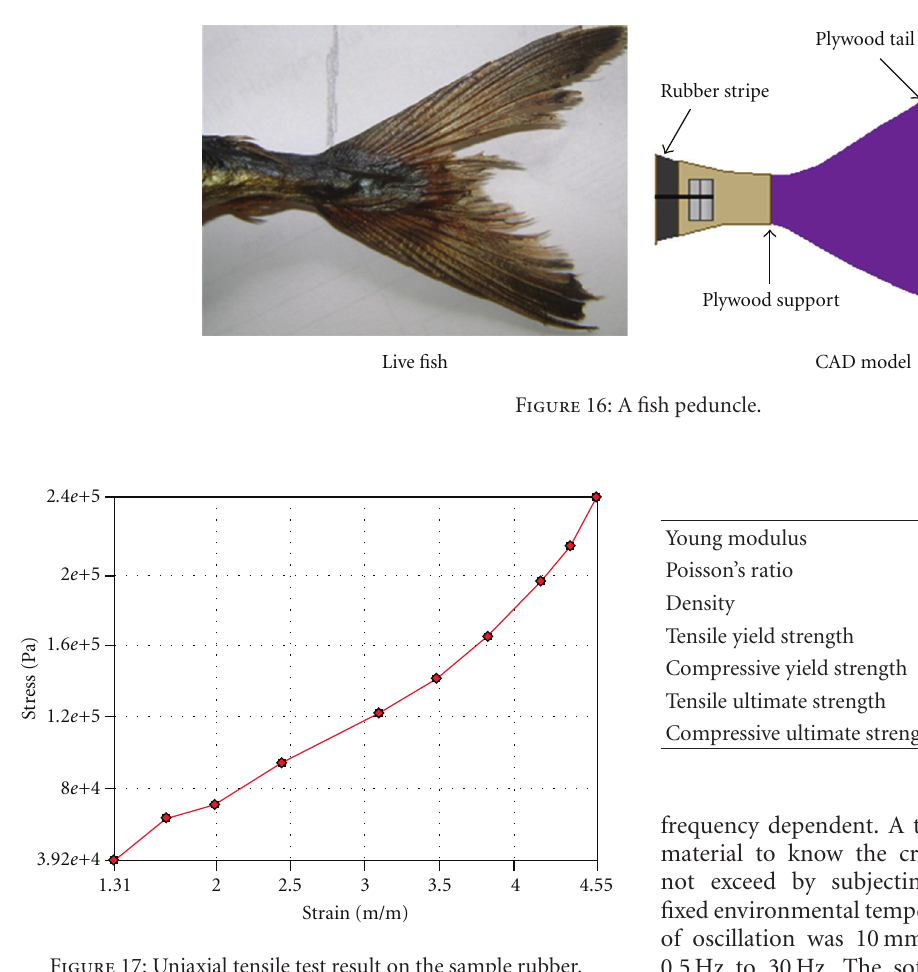
Figure 17: Uniaxial tensile test result on the sample rubber.